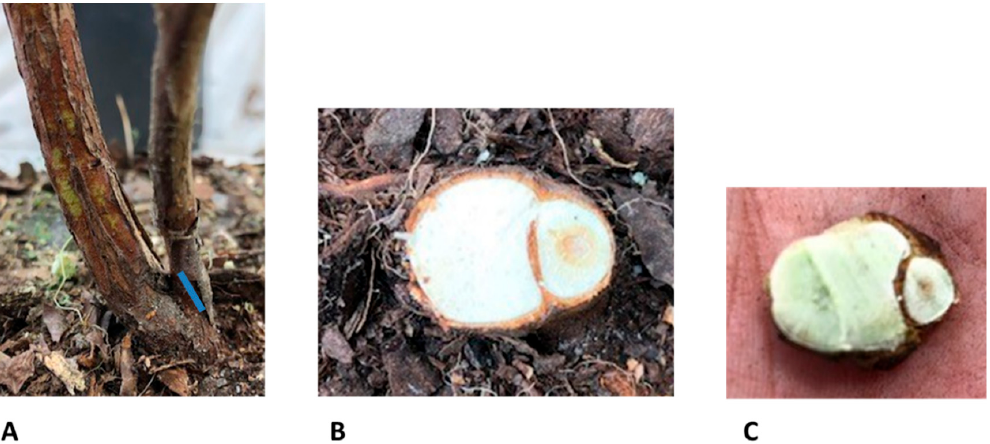
Figure 2. Bark inclusions in trade-gallon potted nursery plants, external ( A ), internal partial ( B ), internal total ( C ). Blue line shows length of external bark inclusion (ridgeline type).